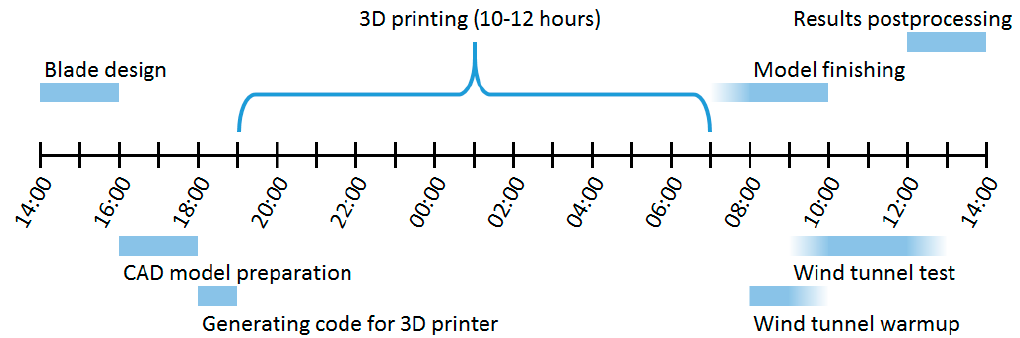
Figure 1. Fast Track—24 h design-to-results process for rotor blade study.